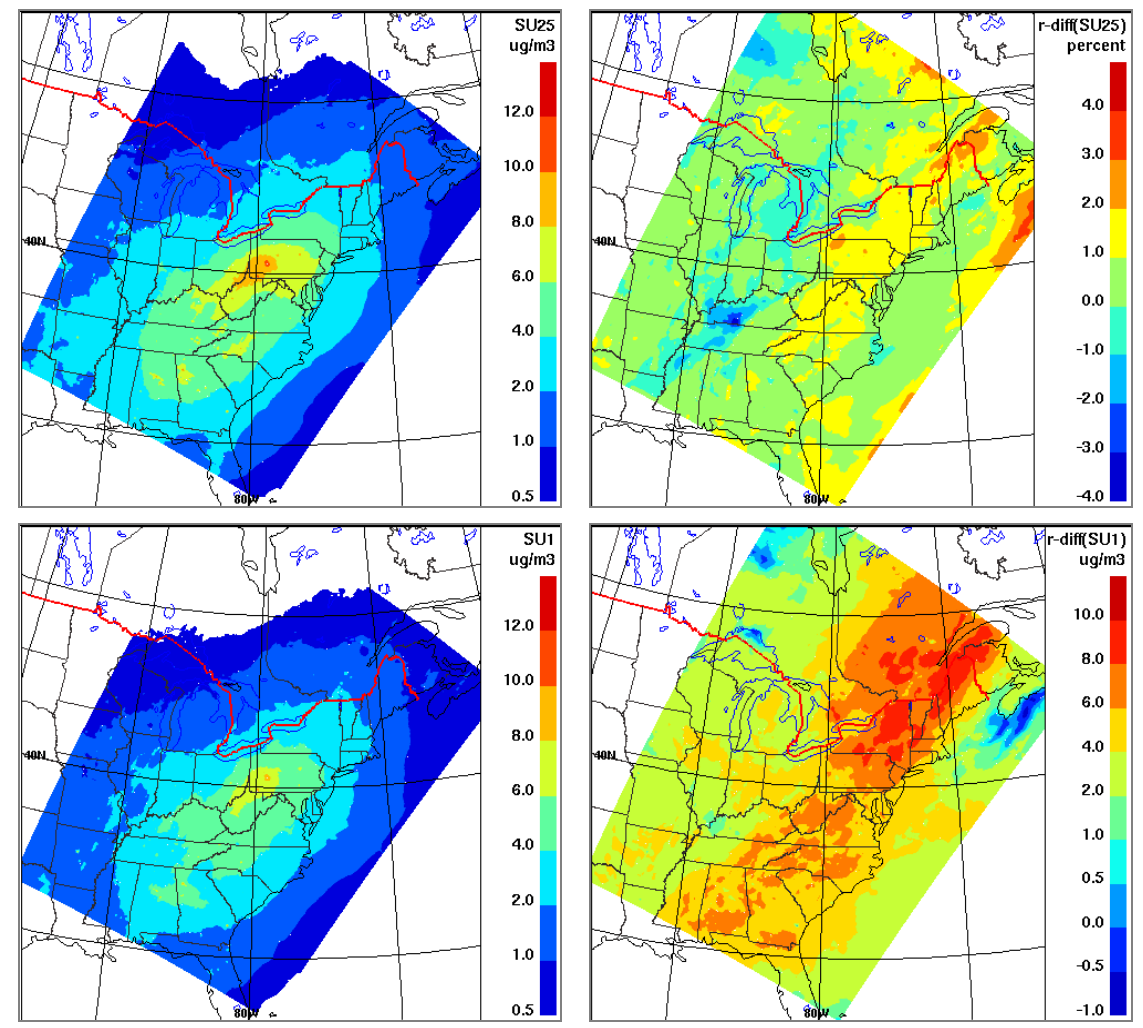
Figure 2. Impact of aerosol activation on modeled ambient sulphate mass: top-left panel—base-case (with Jones scheme) surface sulphate concentration averaged over the 2.5 simulation period; top-right panel—relative difference (in percent) in the modeled average surface sulphate concentrations using the different activation schemes; bottom panels are 2.5 the same as the top ones except for sulphate 1.0